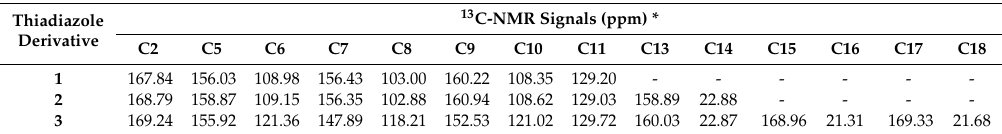
* = numbering system shown in Figure